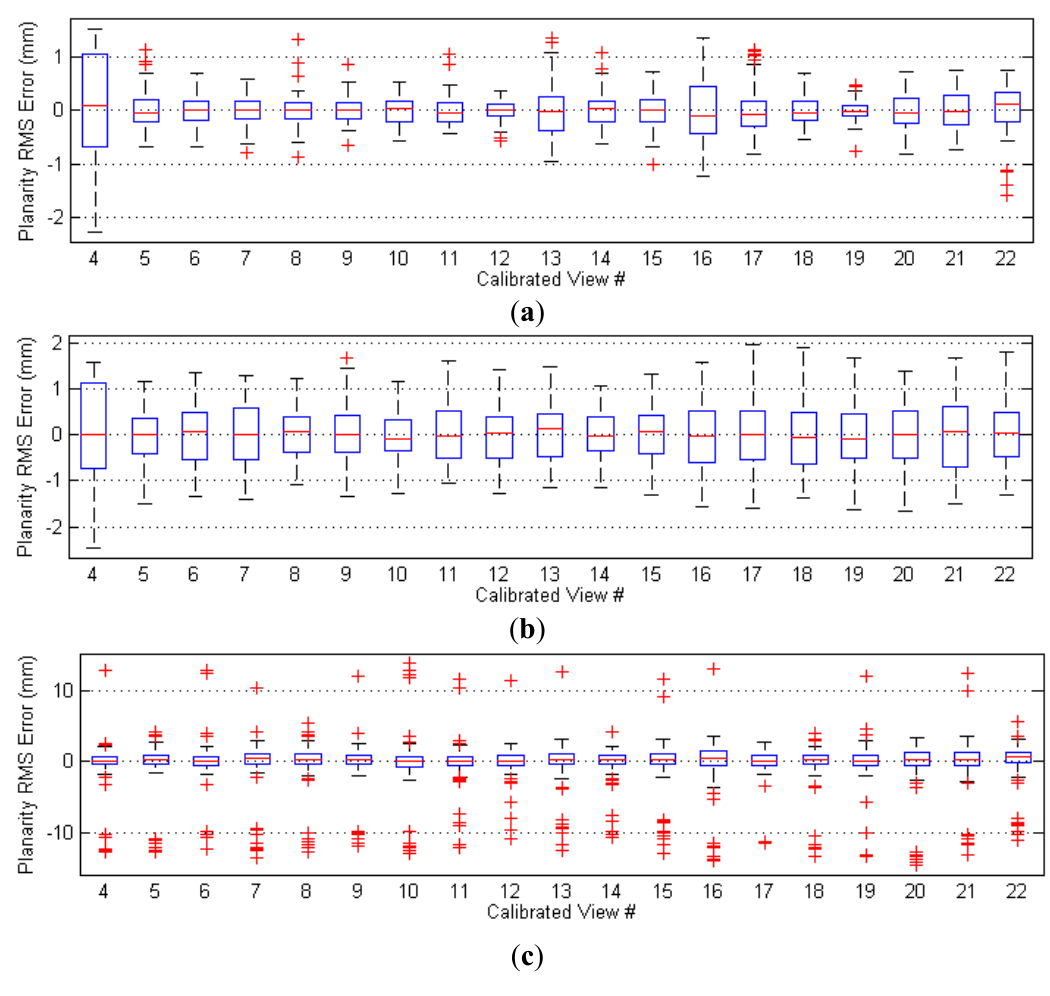
Figure 9. Plane residuals of control points after triangulated using parameters